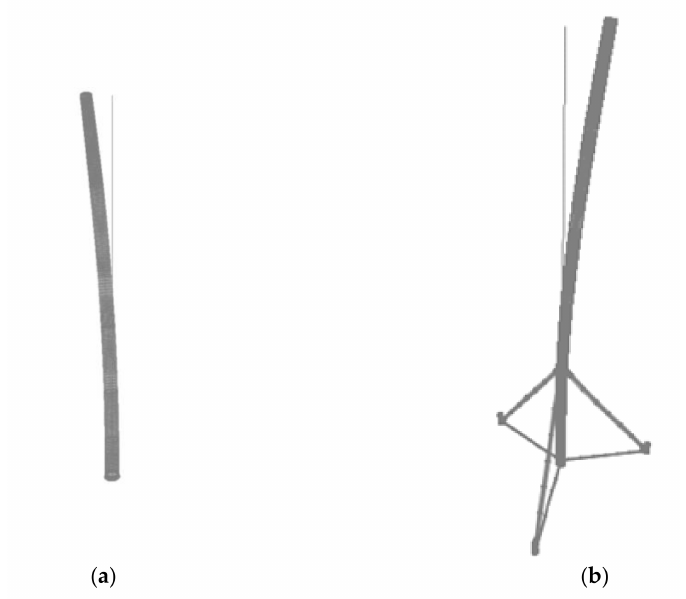
Figure 18. Fundamental vibration modes and corresponding frequencies: ( a ) a typical 120-m-tall tubular tower ( ω 1 = 1.10 rad/s) and ( b ) the overall 180-m-tall tower assembly ( ω 1 = 0.92